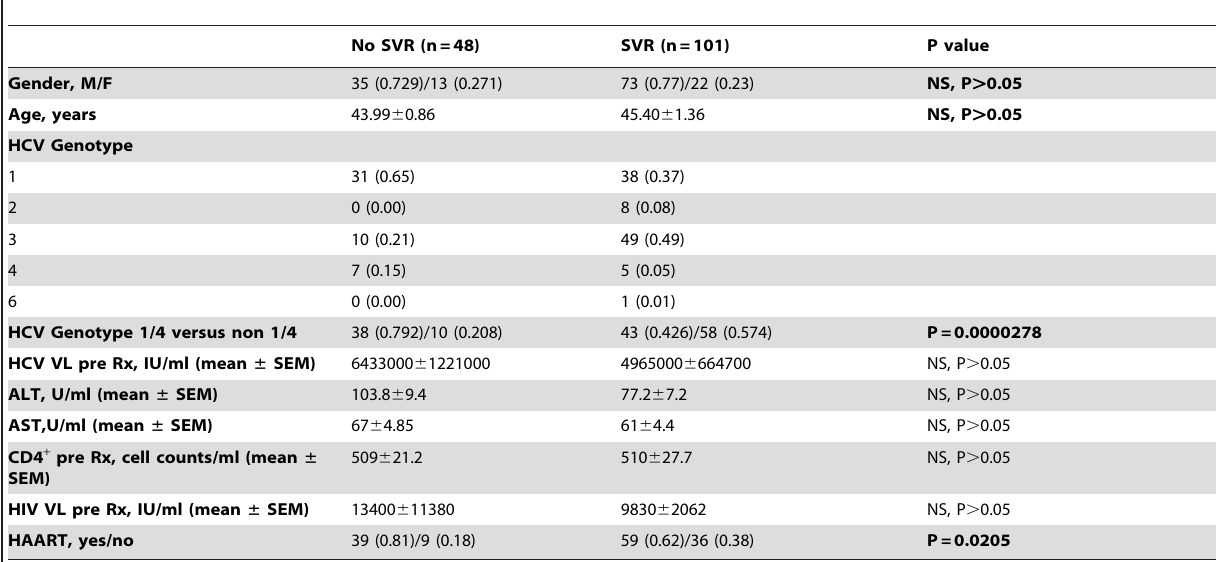
Table 1. Main clinical characteristics of the population included in on-treatment analysis.